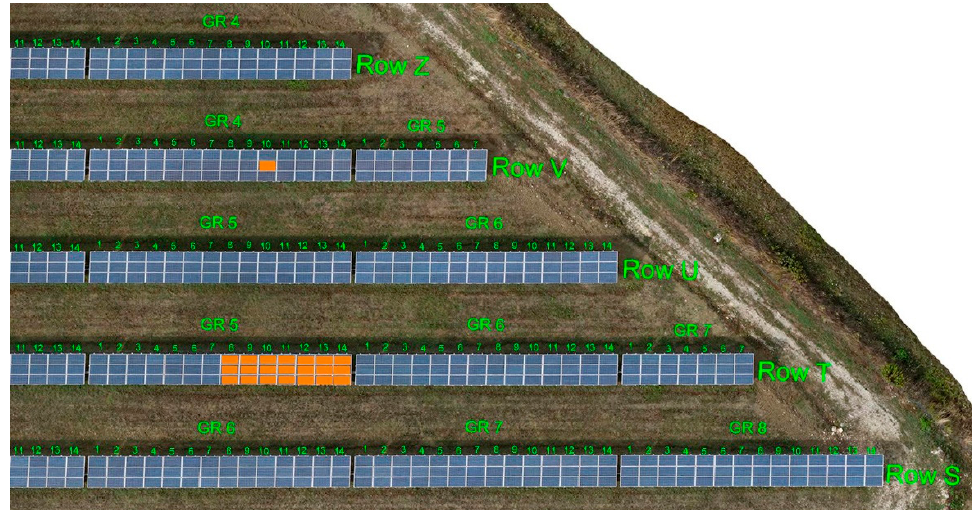
Figure 5. General plan of a portion of the second case study (Plant B), manually created by expert operator.